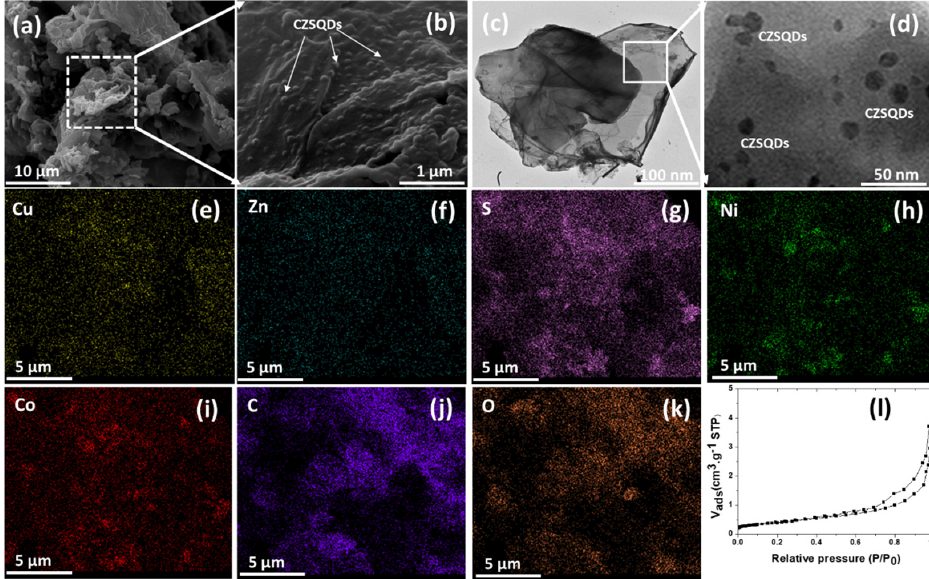
Figure 7. SEM images ( a , b ) and ( c , d ) TEM image of CuZnS QDs-decorated (NiCo)–S@rGOoxdCNT